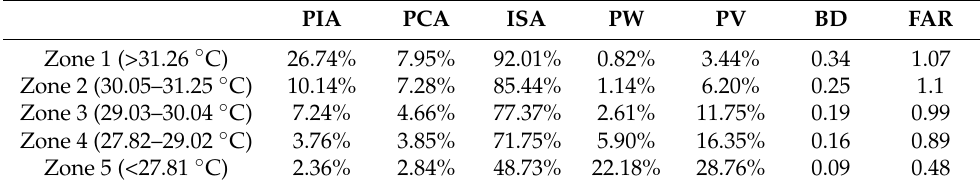
Figure 3. Distribution of LSTs. Table 2. Land use factors in different LST